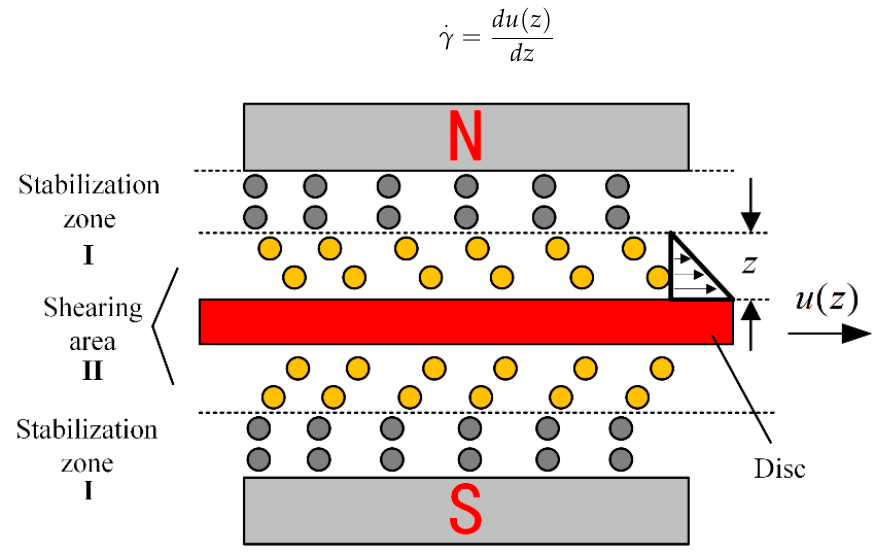
Figure 10. MRF shear force versus velocity